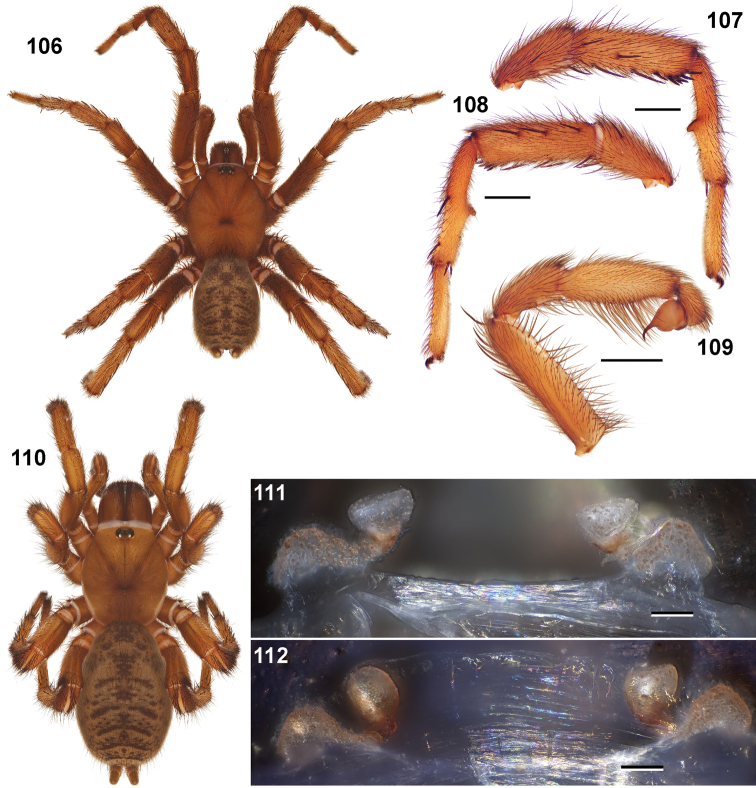
Aptostichus stanfordianus Smith, 1908.106–109 male specimen from Contra Costa Co., Orinda Village (AP162); scale bars = 1.0mm 106 male habitus [805794] 107 retrolateral aspect, right leg I [805784] 108 prolateral aspect, right leg I [805780] 109 retrolateral aspect, right pedipalp [805786] 110, 111 female habitus and cleared spermathecae from Santa Cruz Co. (MY3100) [805790, 805795] 112 cleared spermathecae from Alameda Co., Alameda (AP296) [805776]; scale bars = 0.1mm.